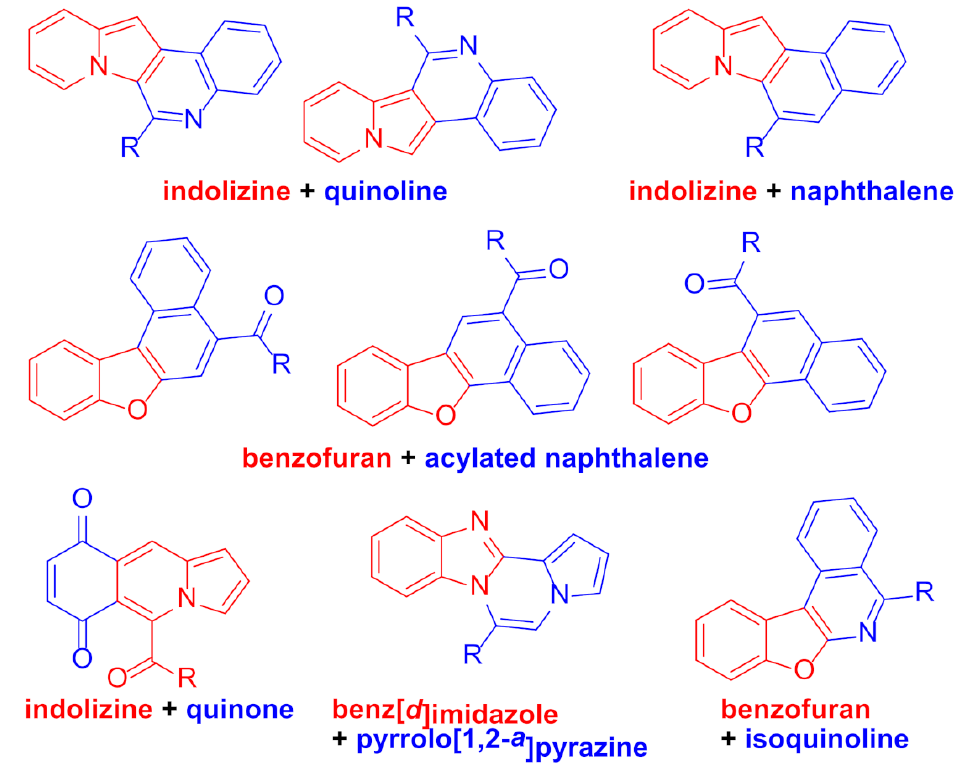
Figure 1. Some Fused Heterocyclic Systems Developed by